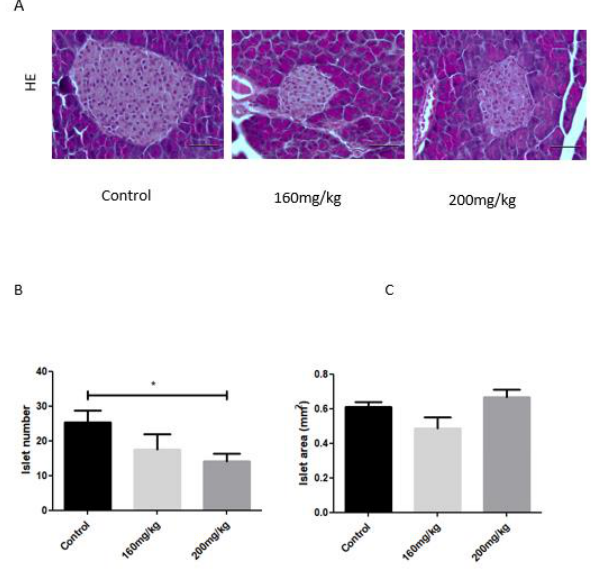
Figure 7. Pancreatic islet morphology in the pancreas of STZ-induced diabetic mice treated with STZ at different concentrations (140–250 mg kg − 1 ). Representative hematoxylin and eosin staining of the islets of Langerhans was examined by light microscopy (magnification, × 10). ( A ). The quantifications of islet number and islet area were determined by ImageJ software ( n = 3; n = 4; n = 6, shown in mm 2 ) ( B , C ). Data are presented as mean SEM. STZ, streptozotocin; Control non-treated mice. Scale bar: 20 µ m. Statistically significant values are marked with (*); p < 0.05.